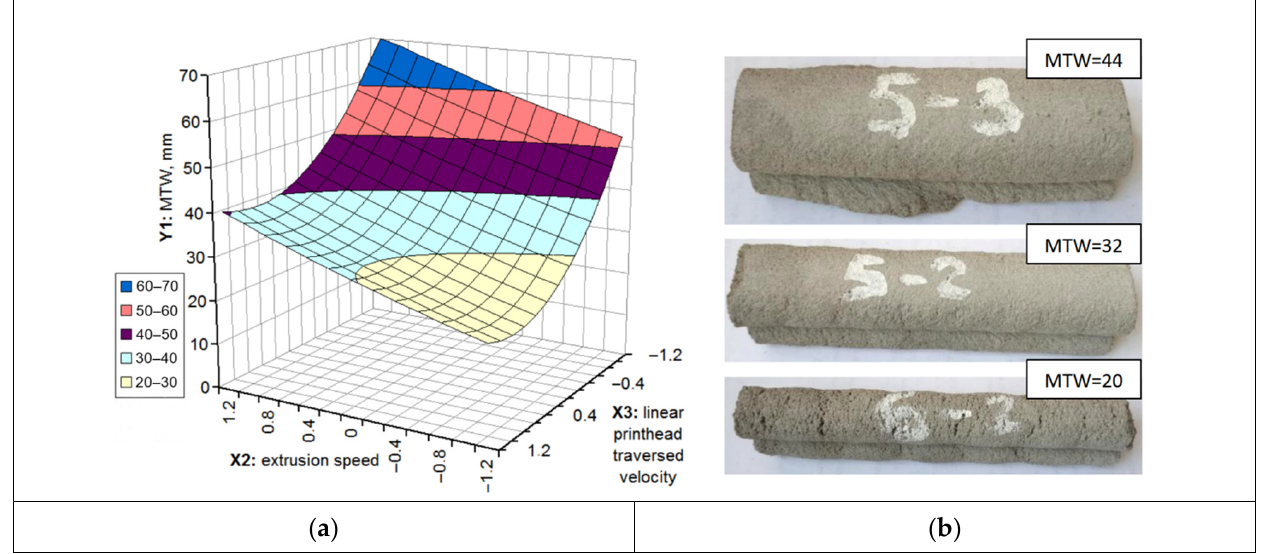
Figure 3. Effect of screw speed and linear printhead traversed velocity of the former on track width Y1 (when X1 = 0): ( a ) graphic representation of relationship between screw speed and linear printhead traversed velocity on track width; ( b ) visual assessment of MTW effect on the samples view. The length of the samples is 150 ± 5 mm .